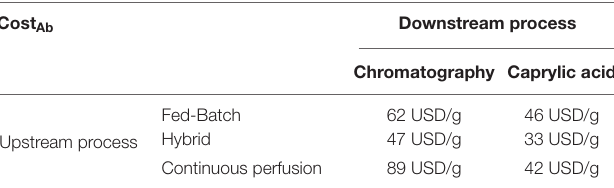
TABLE 3 | Cost estimates for different antibody manufacturing strategies, followed by either chromatographic or caprylic acid purification. Cost Ab Downstream